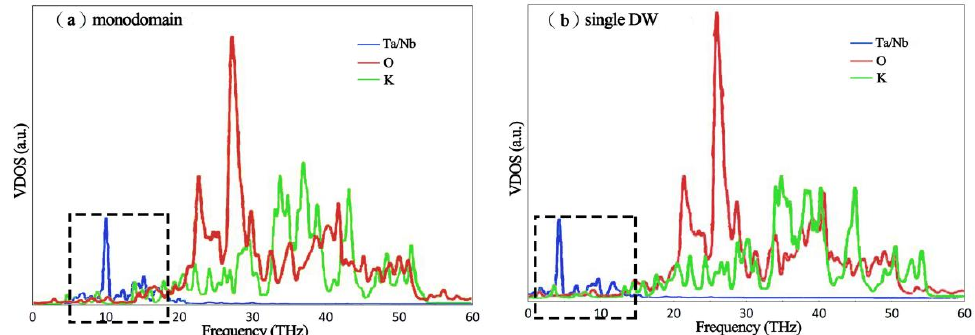
Figure 5. Contribution of each atom to VDOS of KTN: ( a ) monodomain ( b ) single DW.